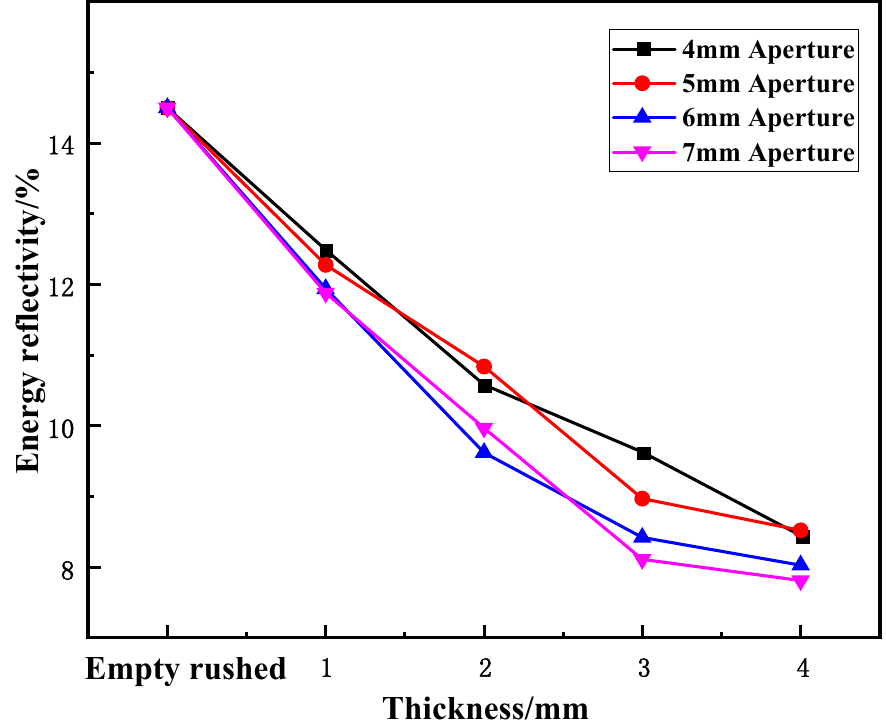
Figure 14. Variation trend of energy reflectance of wave-absorbing metal plate sample with thick- ness.